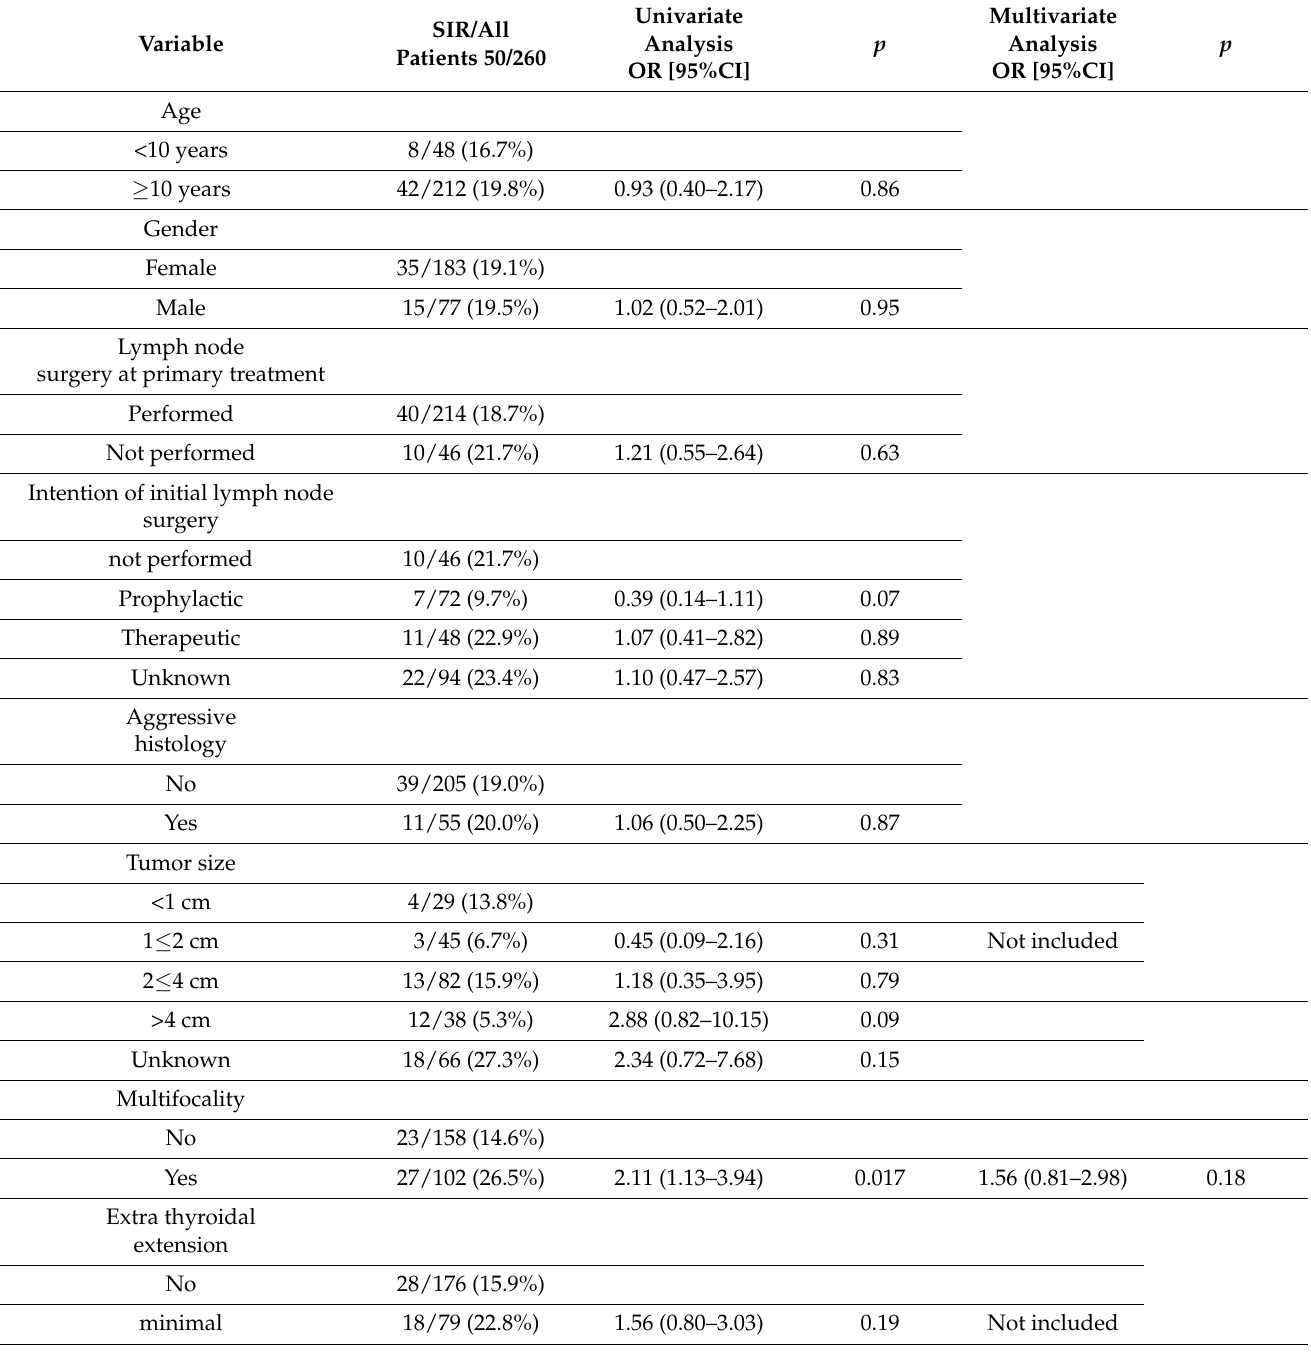
Table 6. Risk factors of structural incomplete response (SIR) disease at last